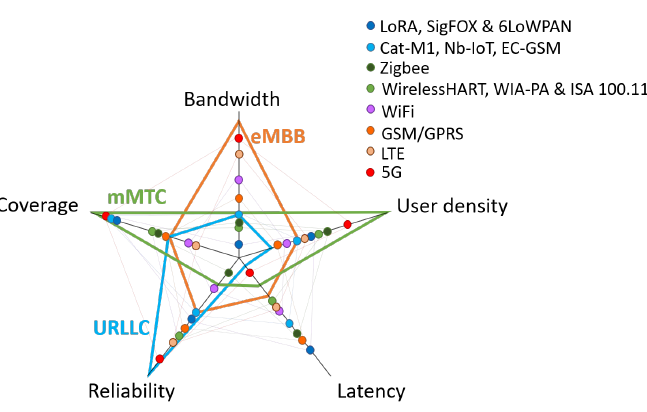
Figure 2. Approximate comparison of wireless technologies for